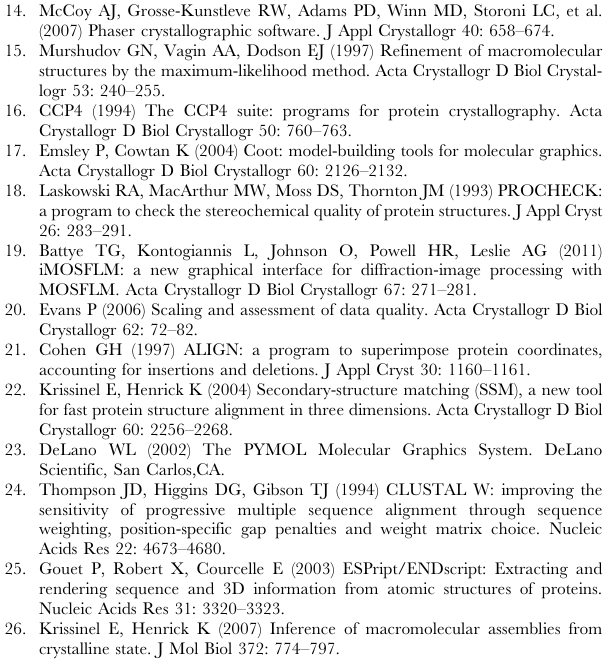
Figure S1 Identification of residues promoting C-ter- minal helix swapping in St SurE. Comparison of sequences of C-terminal variable domain of SurE’s. The secondary structures of domain swapped segments are highlighted. Sequences were aligned using ClustalW and representation of the aligned sequences and secondary structures was obtained by ESPRIPT. 2V4N, 2WQK, 1J9J, 2E6E, 3TY2 and 1L5X are PDB codes of St SurE, Aa SurE, Tm SurE, Tt SurE, Cb SurE and Pa SurE, re- spectively. Arrows indicate the residues that were mutated. B) and C) illustrate interactions stabilising the hinge and favouring swapping of C-terminal helices in St SurE and Aa SurE, re- spectively. Figure S2 Fit of mutated residues. A) 2Fo-Fc (1 s ) map corresponding to residues 230 and 234 in native St SurE. B) 2Fo-Fc (1 s ) map corresponding to residue 234 from chains A (gray) and B